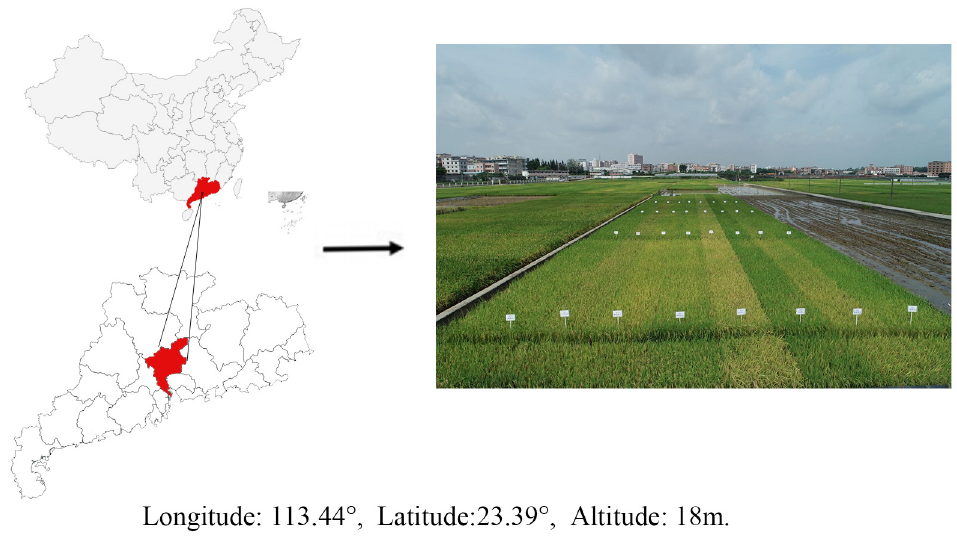
Figure 1. Location of the experimental farm for ground-based and UAV-based field